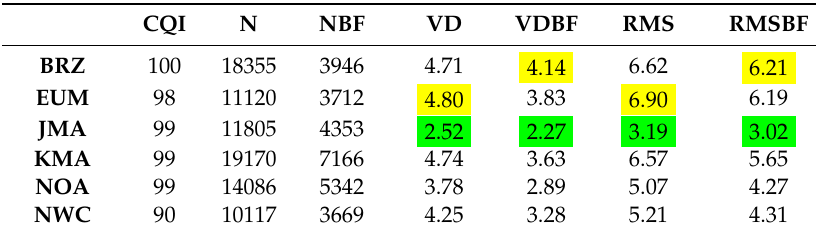
Table 7. Experiment 1: Comparison of all AMVs to NWP analysis winds, with a CQI threshold so that at least 10,000 AMVs are kept. (CQI = Common Quality Indicator Threshold used for each center; N = Number of AMVs; NBF = Number of AMVs with Best-Fit Pressure Value; VD = Vector Di ff erence for all AMVs; VDBF = Vector Di ff erence for AMVs with Best-Fit Pressure Value; RMS = Root Mean Square Error for all AMVs; RMSBF = Root Mean Square Error for AMVs with Best-Fit Pressure Value). The extremes for each category are highlighted; in yellow, the worst value, and in green, the best